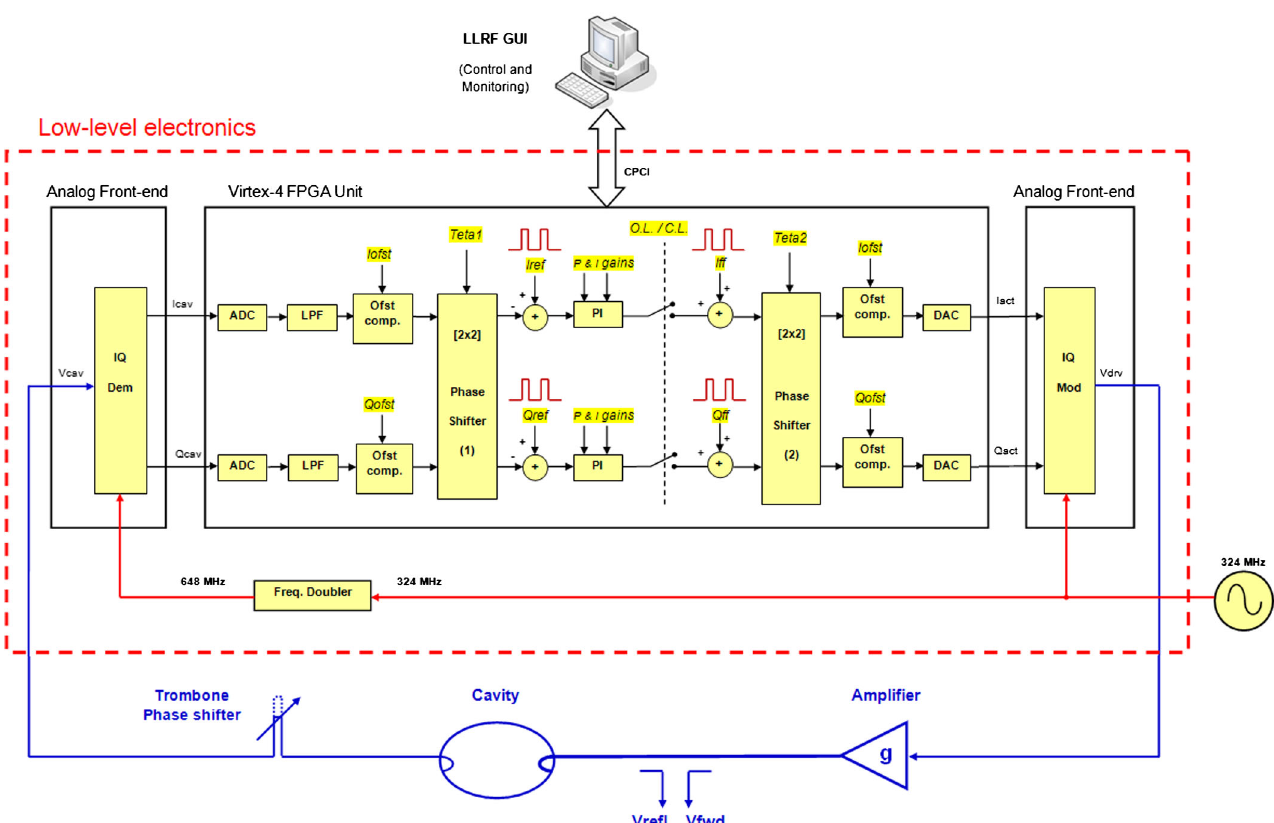
FIG. 7. Simplified block diagram of the FPGA program for amplitude and phase regulation; the parameters marked as italic are set from the control